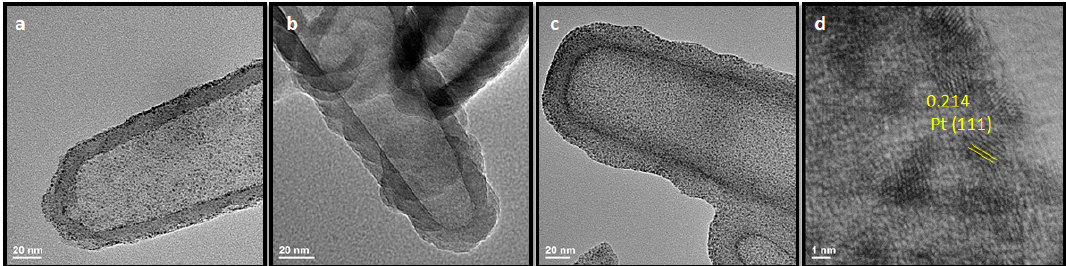
Figure 8. TEM images of SiNTs after incubated in ( a ) impure cisplatin (~15 wt % platinum (Pt), evaluated by erergy dispersive x-ray analysis (EDX), ( b ) pure cisplatin (>95%) (~2 wt % Pt, EDX), ( c ) K 2 PtCl 4 (50 wt % Pt, EDX) . ( d ) High resolution TEM image showing lattice spacing of Pt species deposited on SiNTs after using K 2 PtCl 4 as a Pt precursor.